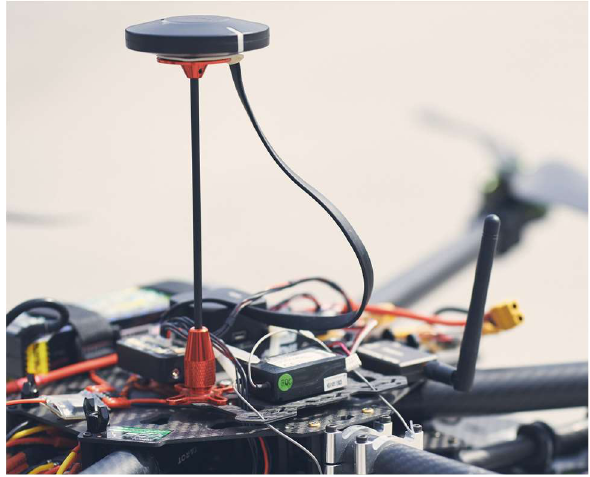
Figure 7. GPS (left) and 433MHz (right) antennas. © Aalto University